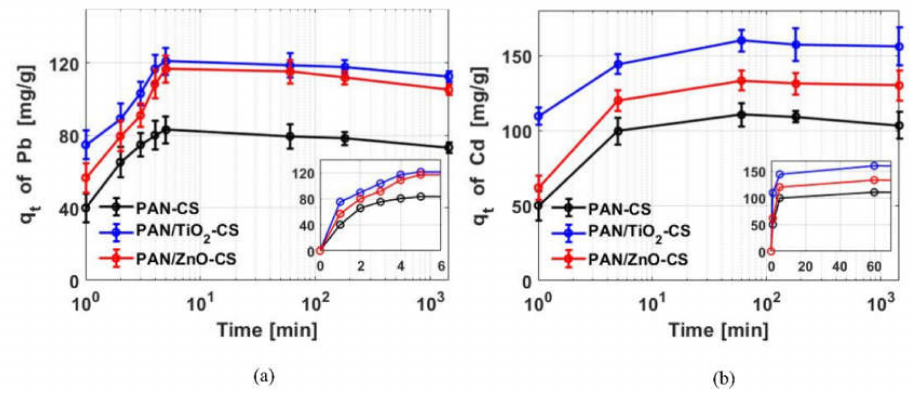
Figure 5. Contact time e ff ect on the capacity of adsorption of ( a ) lead and ( b ) cadmium ions using the bilayer mats. The insets illustrate the adsorption up to the point of equilibrium over a regular (linear) time scale.